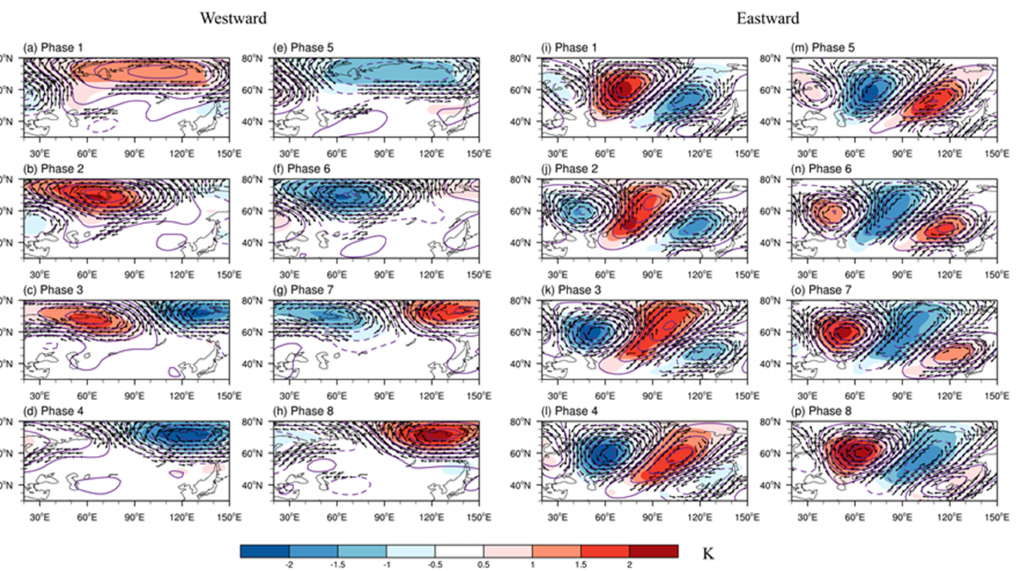
Figure 3. ( a ) Horizontal distribution of 10–30-day − filtered 850 − hPa temperature (shading; unit: K) and 250 − hPa geopotential height (contour interval: 10 gpm; with zero line omitted) and horizontal wind (vector; unit: m s − 1) anomalies in Phase 1 during the westward-propagating mode. ( b − h ) As in ( a ) but for Phase 2 to Phase 8; ( i − p ) As in ( a − h ) but for eastward − propagating mode, all anomalies exceeding the 0.05 significance